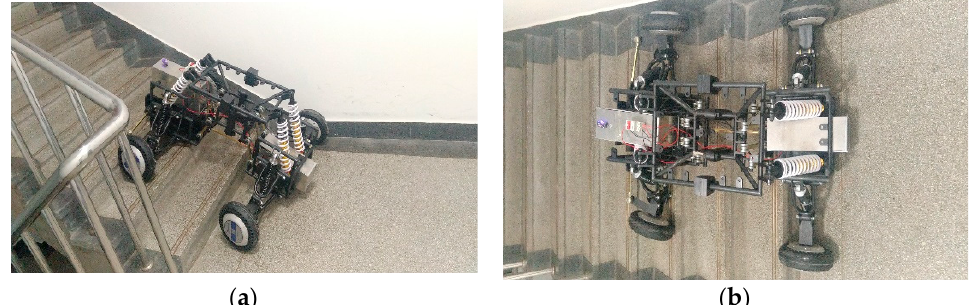
Figure 31. Vehicle crossing beam test. ( a ) Top view of vehicle crossing beam ( b ) Front view of ve- hicle crossing beam